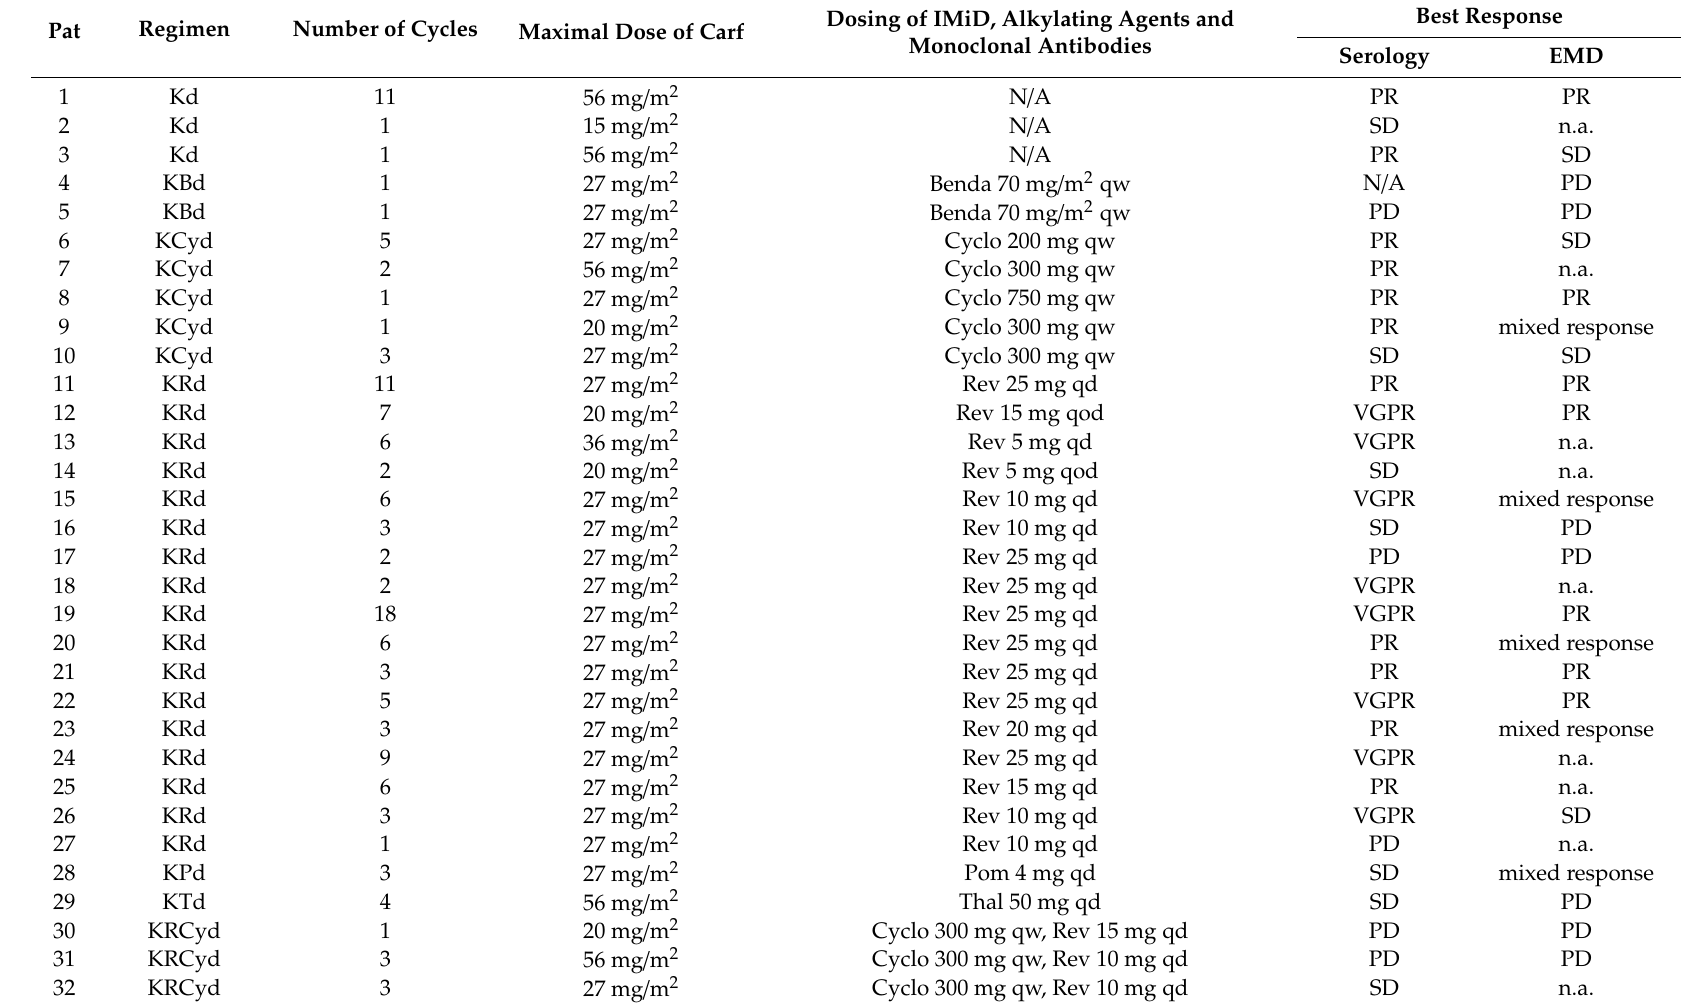
Table 2. Treatment and